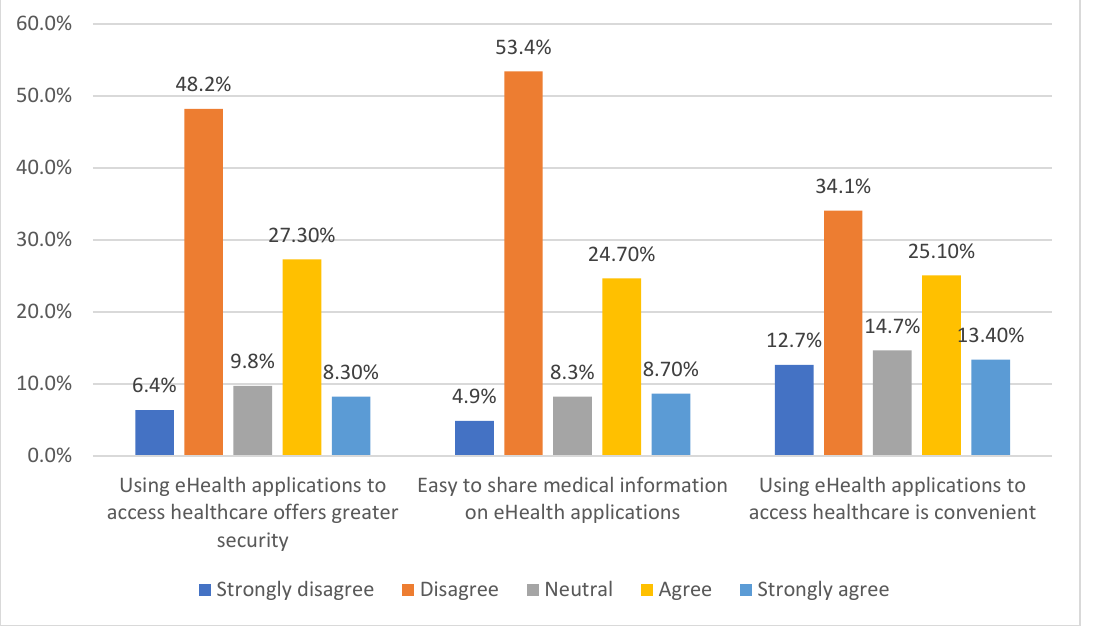
Figure 4. Uses of eHealth applications. Table 4. Difference in opinions among participants groups in relation to eHealth adoption reasons.